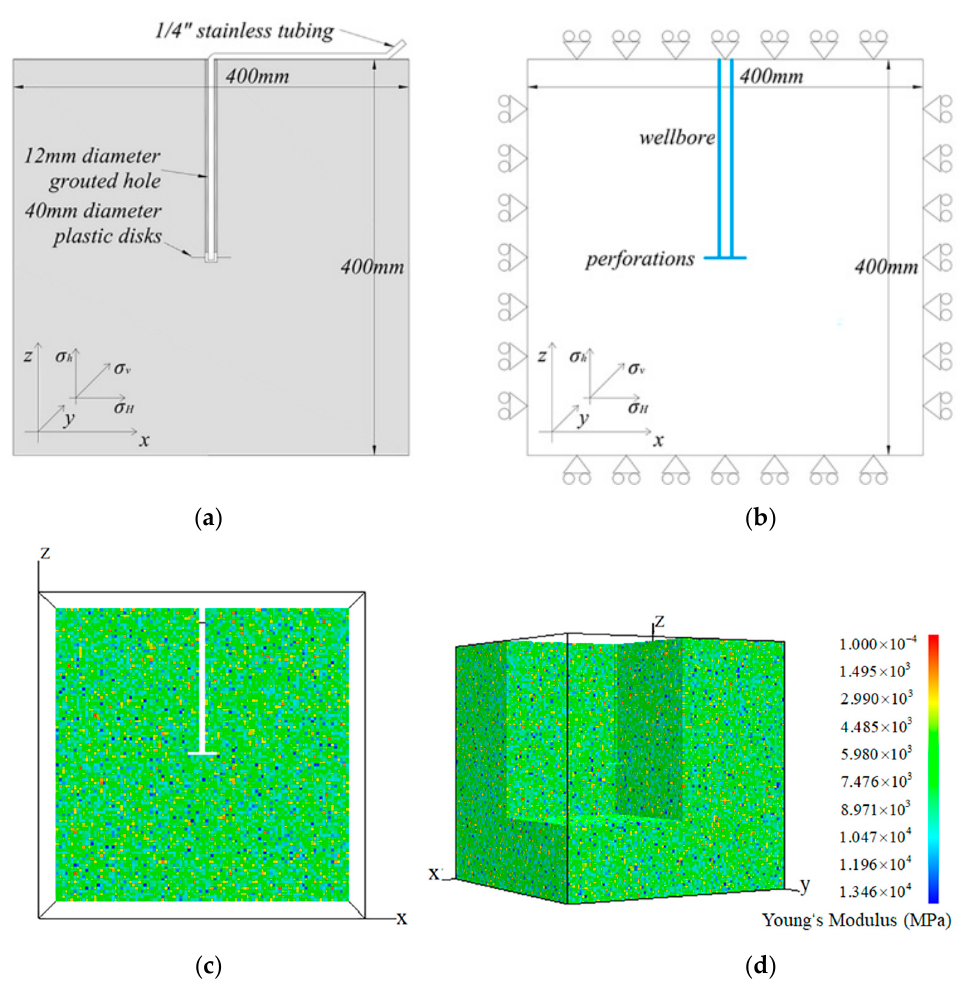
Figure 1. Configuration of the laboratory and simulated “single completion” model. ( a ) Configuration of the “single completion” laboratory test [65], ( b ) conceptual graph for the laboratory model, ( c ) a cross-section at y = 0.2 m of the numerical model built in RFPA, ( d ) cutaway view of the numerical model built in RFPA.